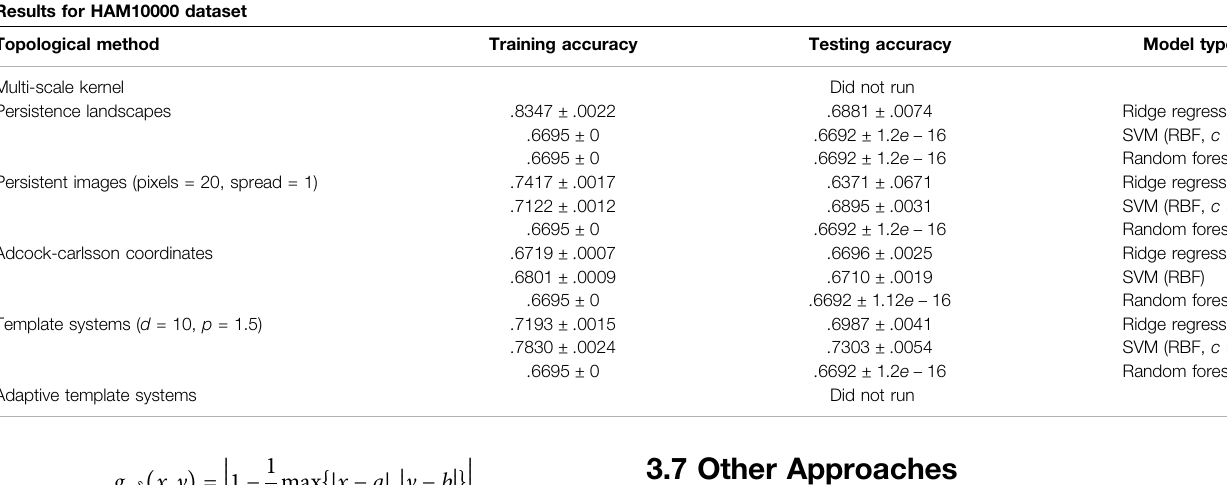
TABLE 5 | Results from the HAM10000 Dataset using the average model classi fi cation accuracy ± standard deviation over 10 trials. Results for HAM10000